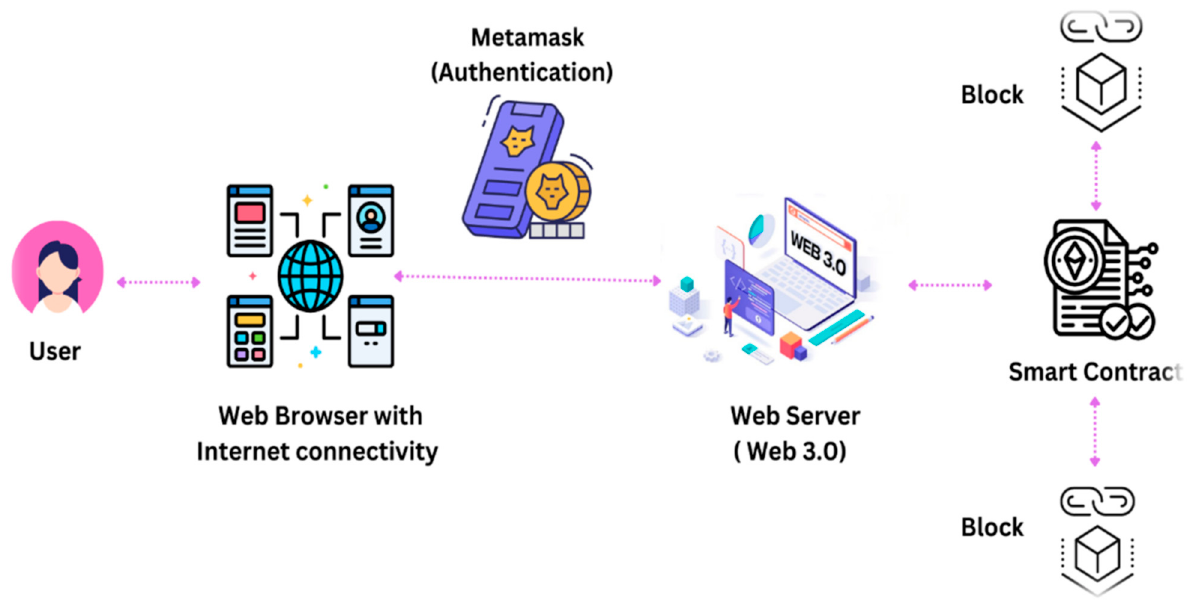
Figure 3. Interaction of dApp and Smart Contract for Consumer Electronics.